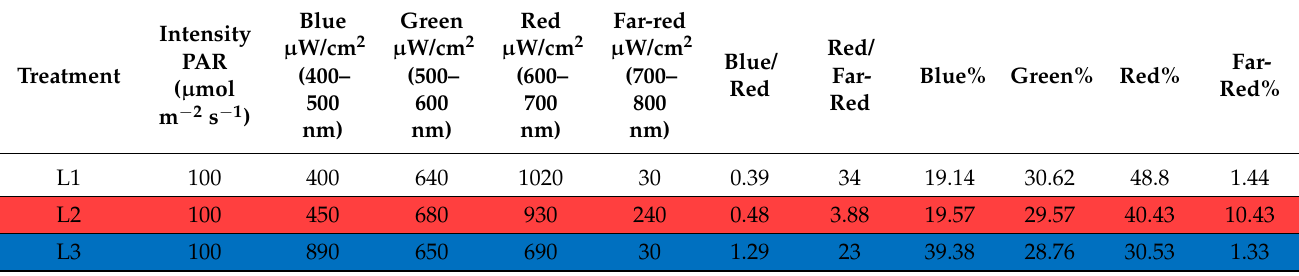
Table 2. Characteristics of the applied three light regimes. Light treatments are colored according to their typical characteristic; the light source for (L1: white color) was a continuous wide-spectrum LED; in the case of the L2 regimen (red color) elevated far-red component was applied, while under L3 light condition (blue color) the blue light component was the most